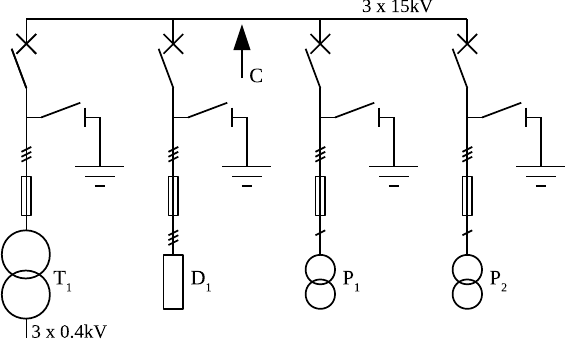
Figure 7. Diagram of the laboratory substation used in the experiment. An arrow C marks the approximate place of the sensor